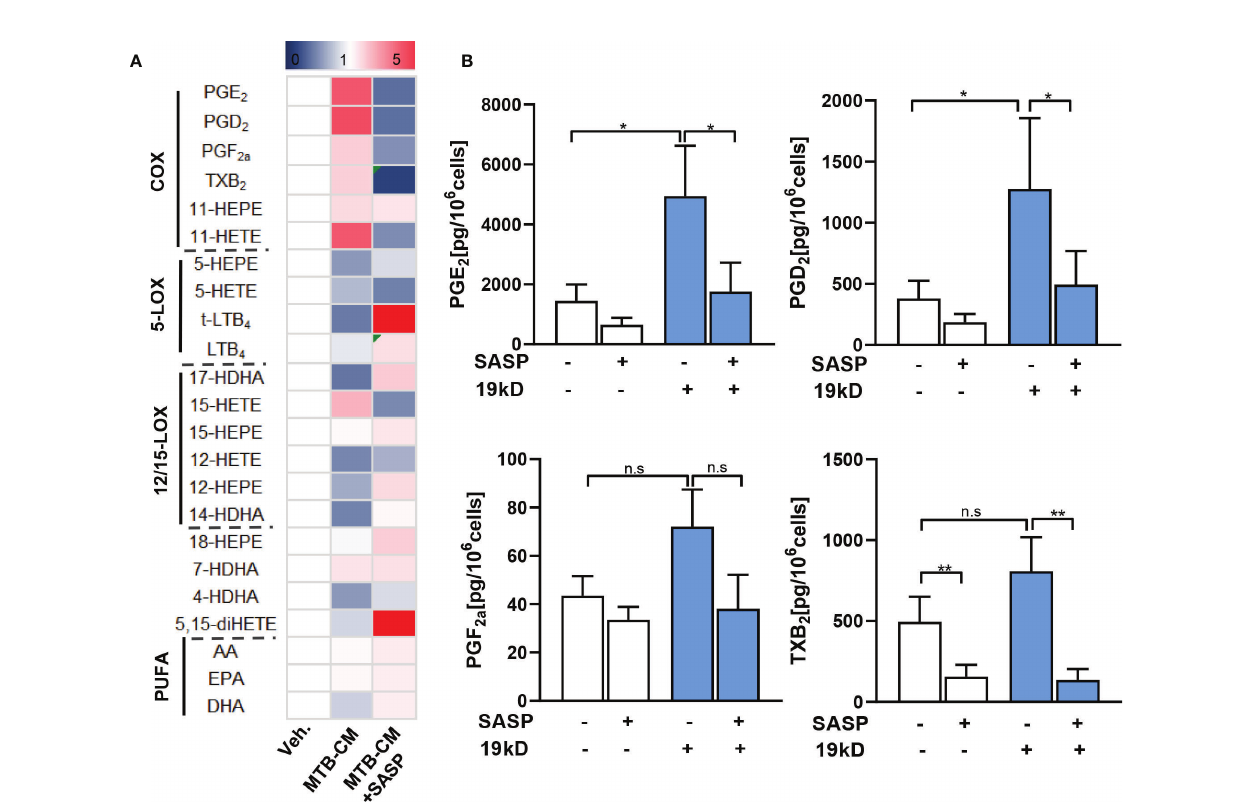
FIGURE 5 | Lipid mediator biosynthesis in M1-MDM exposed to the 19-kD antigen. Human monocytes were differentiated towards M0 GM-CSF MDM and then polarized for 48 h with 100 ng/ml LPS plus 20 ng/ml IFN- g to obtain M1-MDM. Cells were then pre-treated with 200 m M SASP or vehicle (veh., 0.1% DMSO) for 1 h and then incubated for 4 h with or without the 19-kD antigen (2 µg/ml) at 37°C. Formed LM were extracted from the supernatants and analyzed by UPLC – MS-MS; detection limit: 0.5 pg. (A) Relative changes of LM given as means, shown in a heatmap, n = 3 separate donors. (B) Absolute values of single COX products (PGE 2 , PGD 2 , PGF 2 a , TXB 2 ) given in pg/ml; data are means ± S.E.M., n =3. Data were log-transformed for statistical analysis by paired t test; *p ≤ 0.05, **p ≤ 0.01. n.s., not signi fi